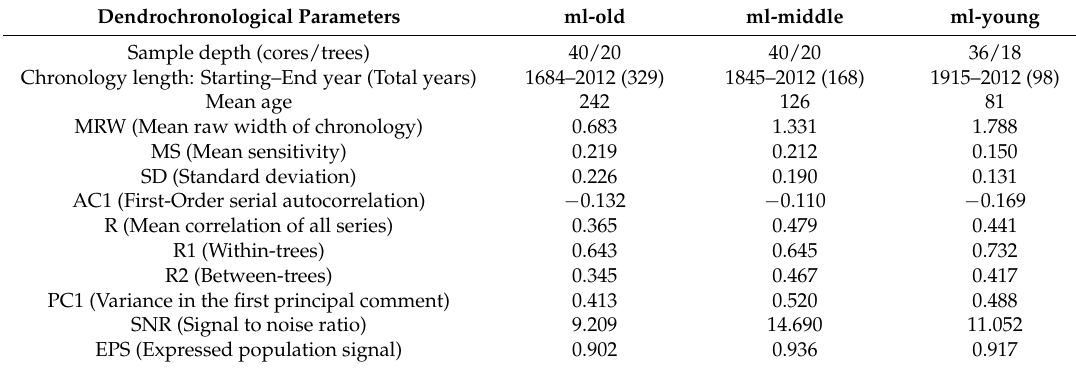
Table 1. Dendrochronological characteristics of Schrenk spruce tree-ring width chronologies from three age-classes of trees during 1960–2012 in the eastern Tianshan Mountains, northwest